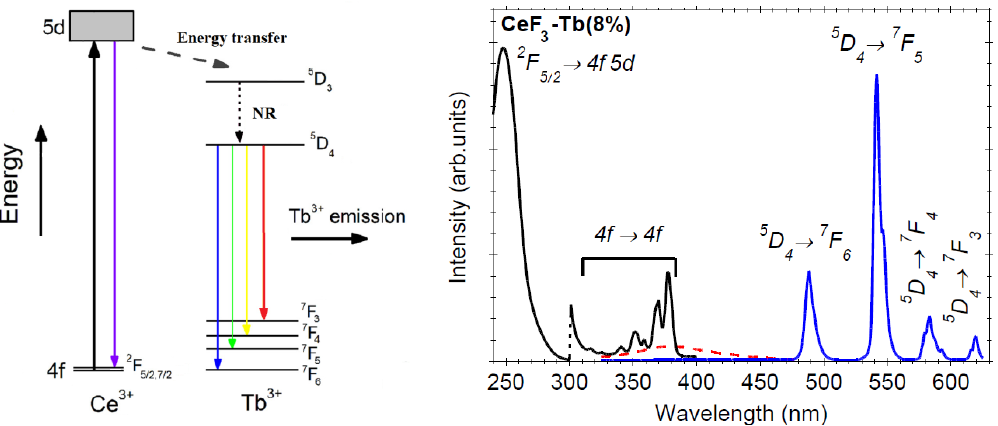
Figure 7. Energy level scheme of the Ce 3+ and Tb 3+ ions ( left ) and the photoluminescence excited at 250 nm with the excitation spectrum of the 545 nm luminescence recorded on CeF 3 :Tb nanocrystalline powder calcinated at 400 °C ( right ); photoluminescence of undoped CeF 3 nanocrystalline sample is shown for comparison (dotted curve).